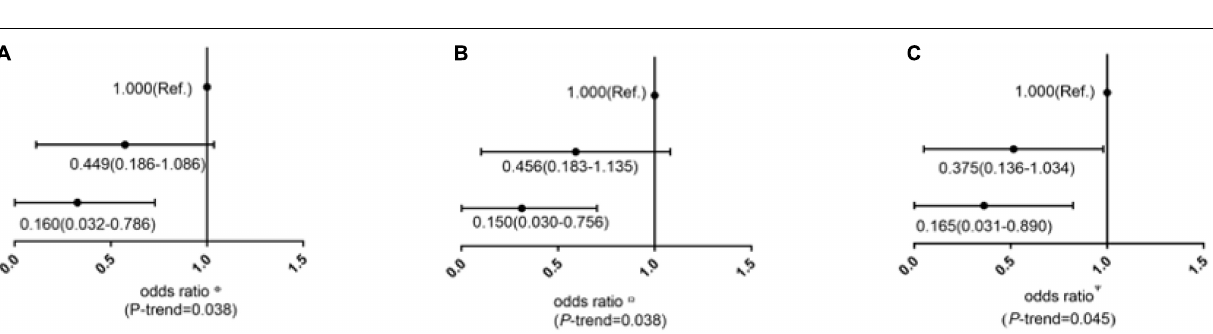
FIGURE 3 | Differences of the SCL-90 among nut intake < 1 time/week, nut intake 1–7 times/week, and nut intake > 7 times/week. (A) Differences in total and nine different symptom clusters of psychopathologies scores of SCL-90 among different nut intake frequencies groups. (B) Differences in the prevalence rate of psychological problems among different nut intake frequencies groups. SOM, somatization; O–C, obsessive–compulsive behavior; I–S, interpersonal sensitivity; DEP, depression; ANX, anxiety; HOS, hostility; PHOB, phobic anxiety; PAR, paranoid ideation; PSY, psychoticism. * P -value < 0.05.